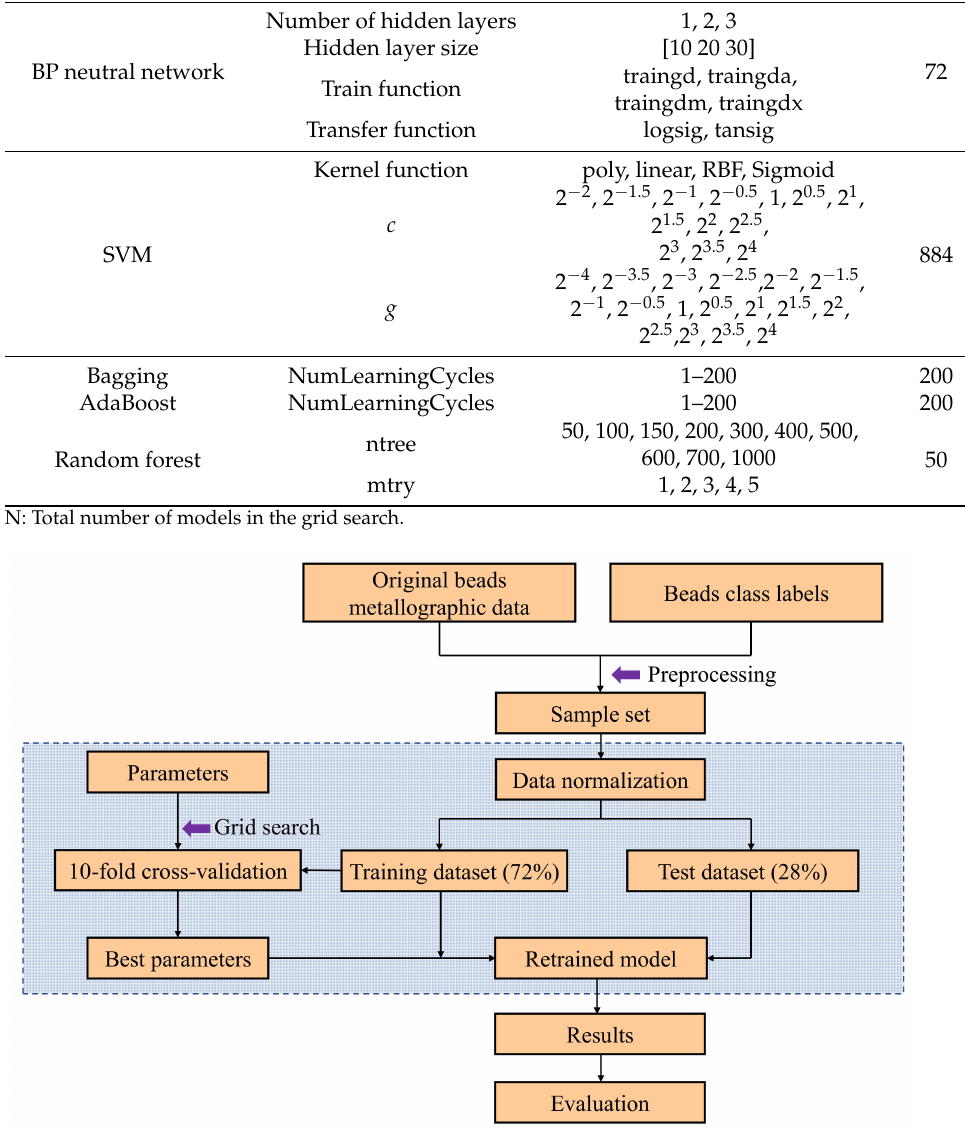
Figure 5. Flowchart of model training, testing, and